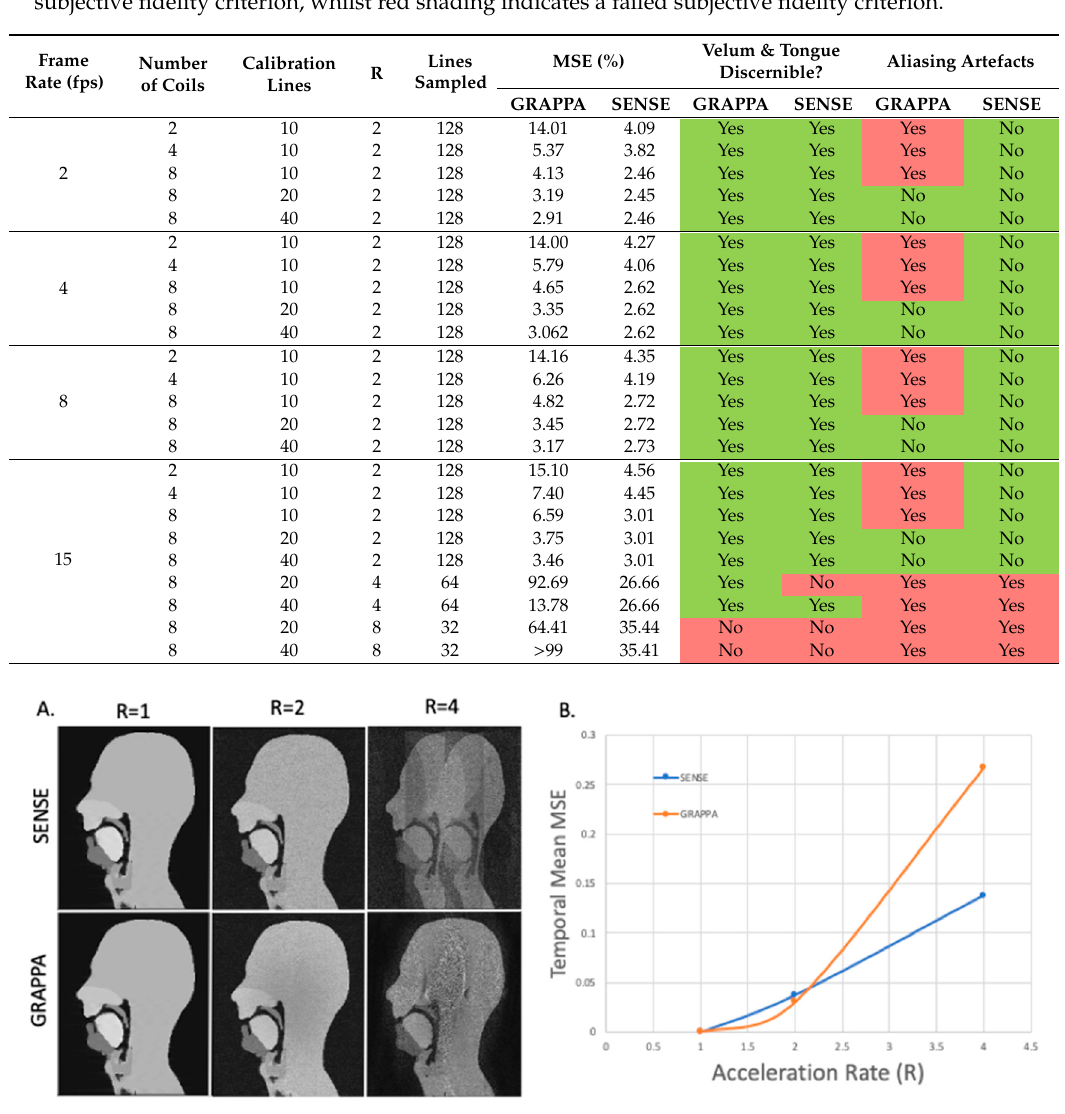
Figure 12. ( A ) GRAPPA and SENSE reconstructions for a simulated 8-element coil with increasing acceleration factor 2 and a 40-line auto-calibration signal (ACS) region (for GRAPPA). ( B ) Temporal mean root mean squared error (RMSE) compared to R = 1 for each of the associated reconstructions.